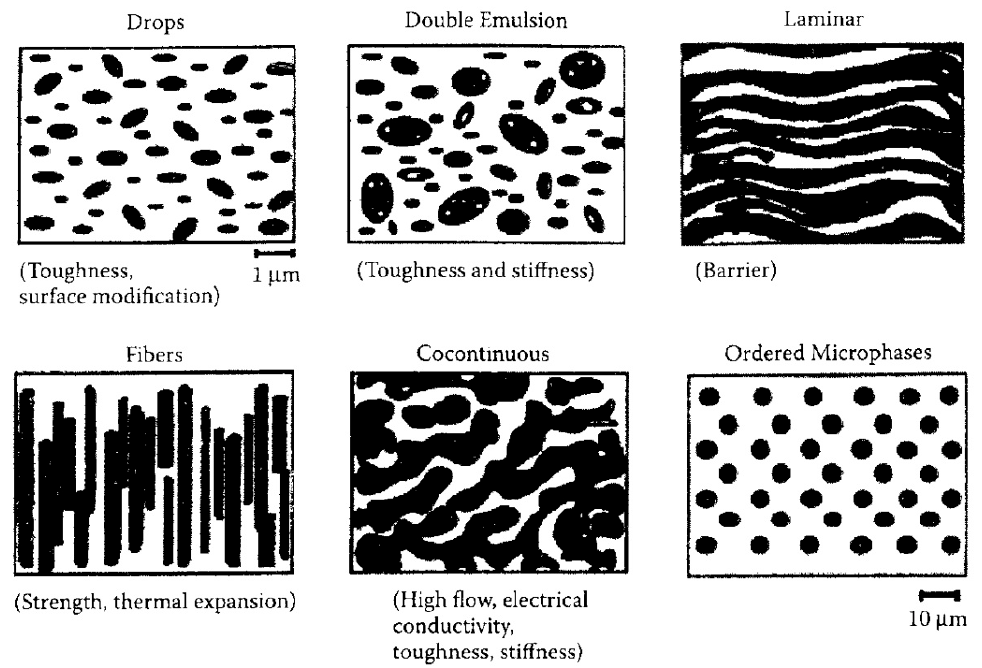
Figure 2. Schematic of morphologies which can produced by polymer–polymer melt blending [33]. Reused with permission from W. Macosko Christopher, Macromolecular Symposia; published by John Wiley and Sons, 2000.